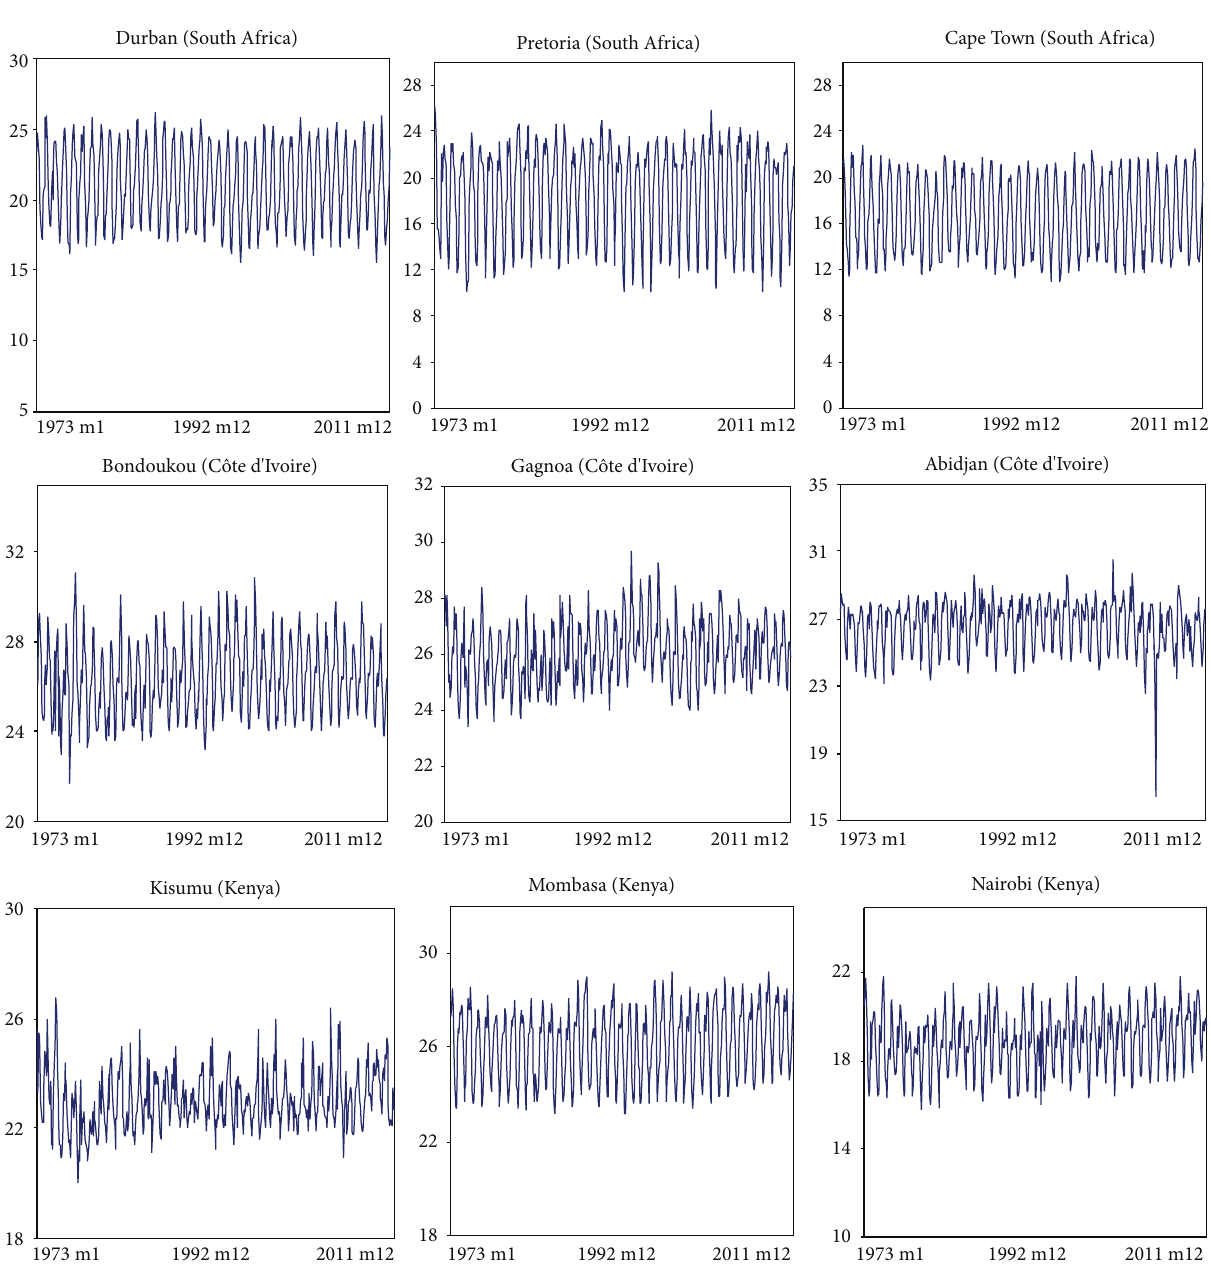
Figure 1: Original time